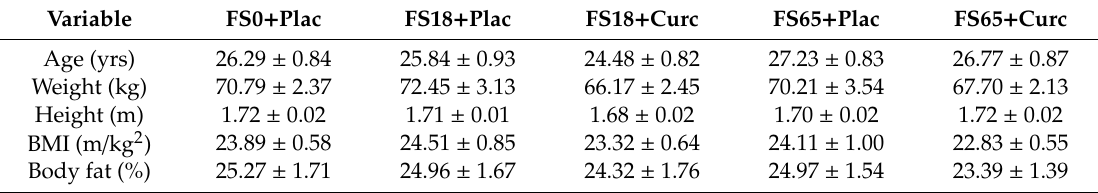
Table 1. Participant age, weight, height, body mass index (BMI) and body fat percentages (mean ± SEM).